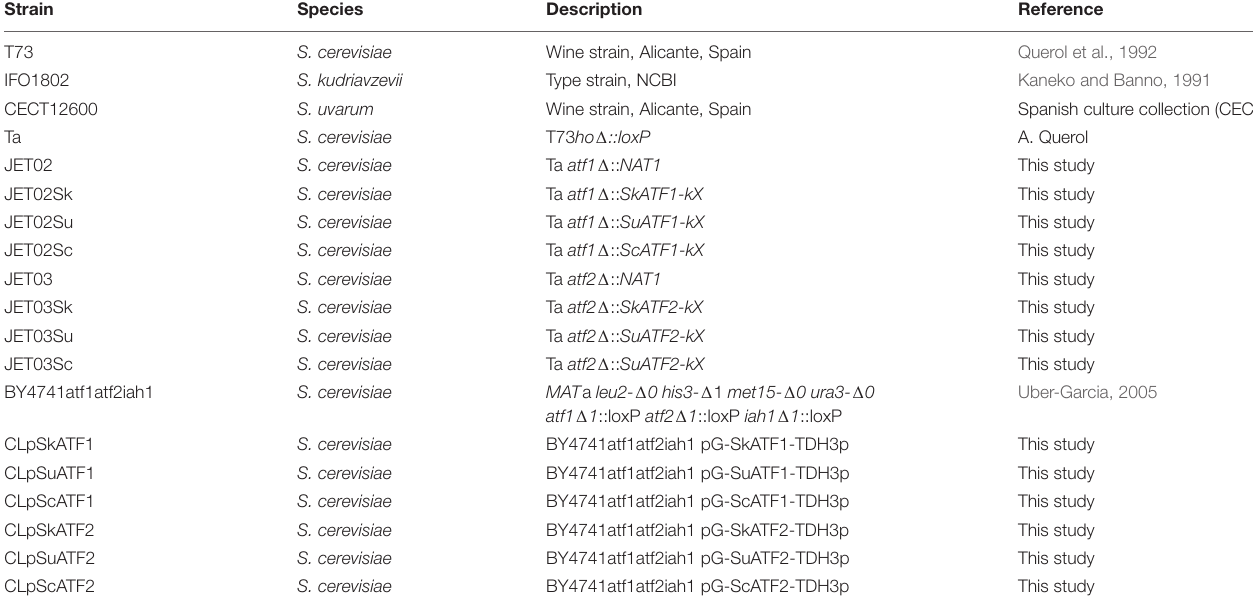
TABLE 1 | List of the yeast strains used in this